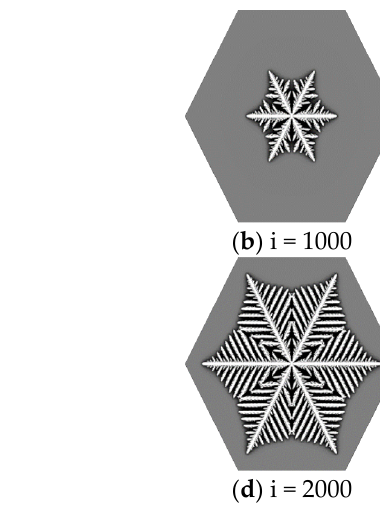
Figure 6. Snowflake simulation of the CA